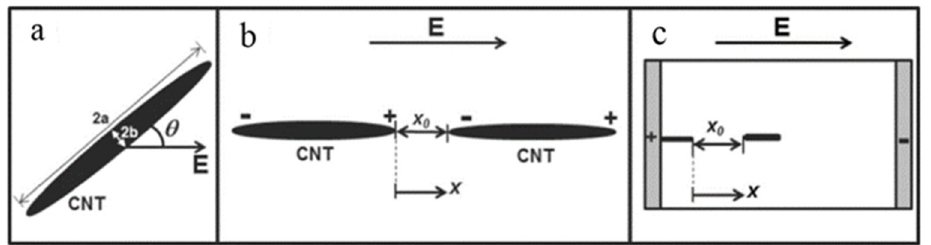
Figure 13. Schematics of the three dynamic mechanisms of CNT under applied AC electric fields: ( a ) CNT rotation, ( b ) Coulombic interaction between CNTs, ( c ) CNT migration towards an electrode. Reproduced with permission [89]. Copyright 2014, Elsevier.